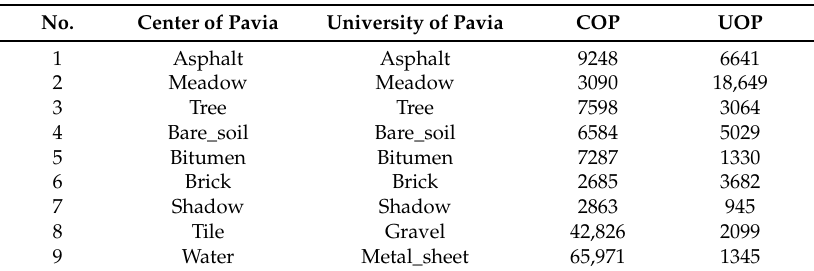
Figure 3. ROSIS data, three-channel color composite of the areas used for the classification: ( a ) University area; ( b ) Ground reference map of university; ( c ) Pavia center; ( d ) Ground reference map of center. Table 2. Information classes and true samples of COP and UOP.